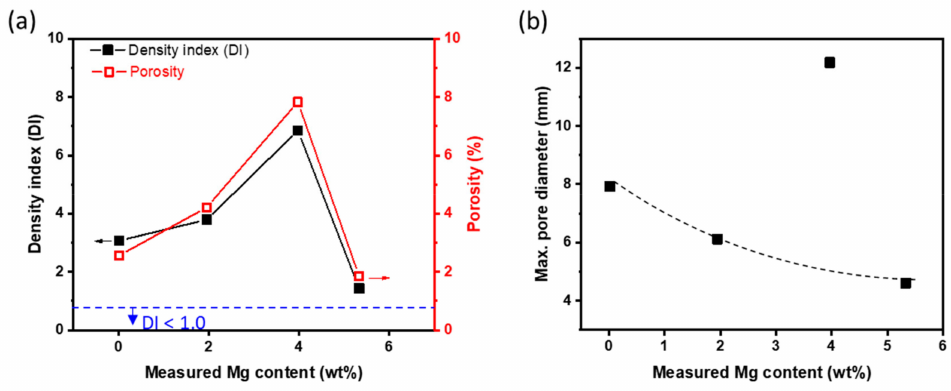
Figure 3. Density index (DI) and porosity ( a ), and maximum pore diameter ( b ) of Al-Mg alloys cast at 800 ◦ C as a function of Mg content.